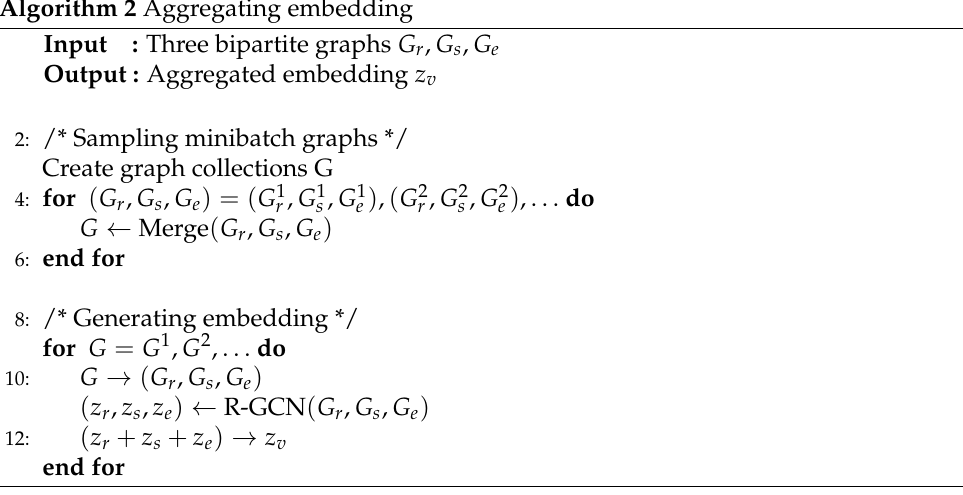
Algorithm 2 Aggregating